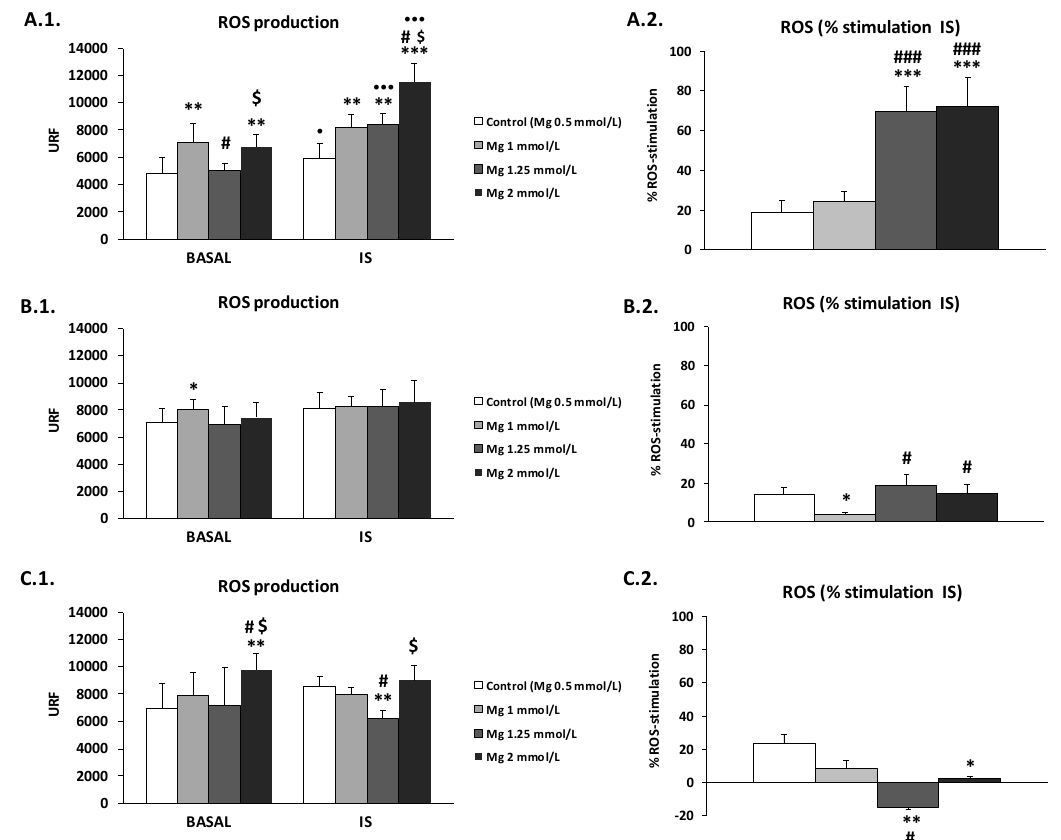
Figure 3. Intracellular reactive oxygen species (ROS) production under basal conditions and in response to indoxyl sulfate (IS) treatment (256 µ g / mL) in human THP-1 monocytes cultured in ( A ) ADF (acetate 3 mM), ( B ) ACDF (citrate 0.3 mM + acetate 0.8 mM), and ( C ) CDF (citrate 1 mM) dialysates with standard (0.5 mM, control) or with high Mg concentrations (1, 1.25, and 2 mM). ( 1 ) ROS levels (URF) and ( 2 ) percentage (%) of increases in ROS production after 180 min of stimulation with IS. Each column represents the mean ± SD of 5–8 independent experiments. * p < 0.05, ** p < 0.01, and *** p < 0.001 vs. the corresponding 0.5 mM Mg (control). # p < 0.05 and ### p < 0.001 vs. the corresponding 1 mM Mg. $ p < 0.05 vs. the corresponding 1.25 mM Mg. • p < 0.05 and ••• p < 0.001 vs. the corresponding basal